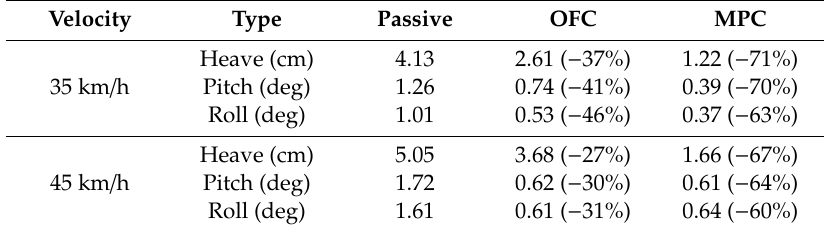
Table 1. Root-mean-square (RMS) values of vehicle heave, pitch, and roll at different speeds. Velocity Type Passive OFC MPC Heave 35 km / h